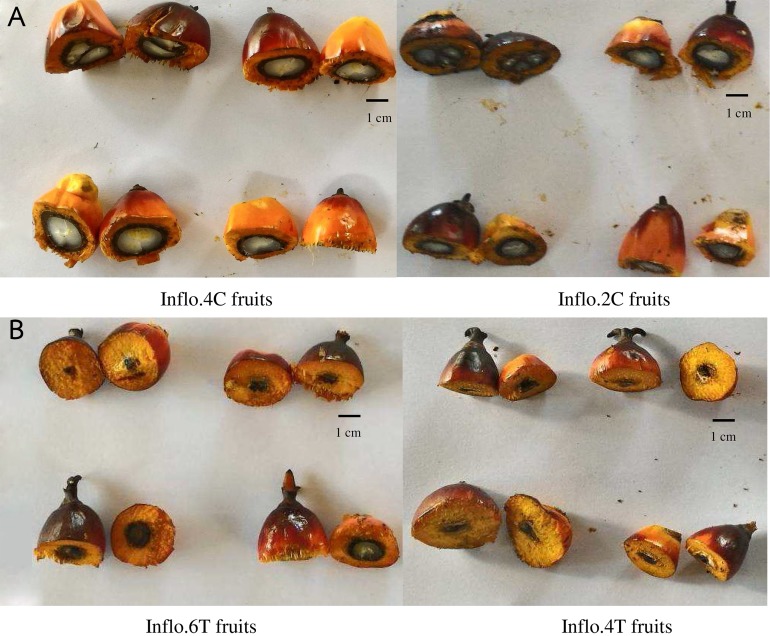
A comparison of oil palm fruit cross sections between the control fruits of Inflo.4C and Inflo.2C (A), without auxin treatment, and the auxin treated fruits of Inflo.6T and Inflo.4T, which had 50% and 90% parthenocarpy, respectively (B).The auxin treatment was first sprayed on DAP = 1 of anthesis. cm = size indicator in centimeter.